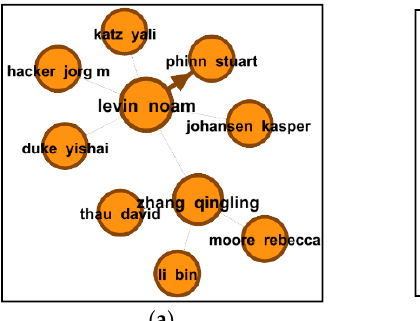
Figure 8. Kyba, C.–Kuechly, H. research community: ( a ) co-author network; ( b ) related topics.